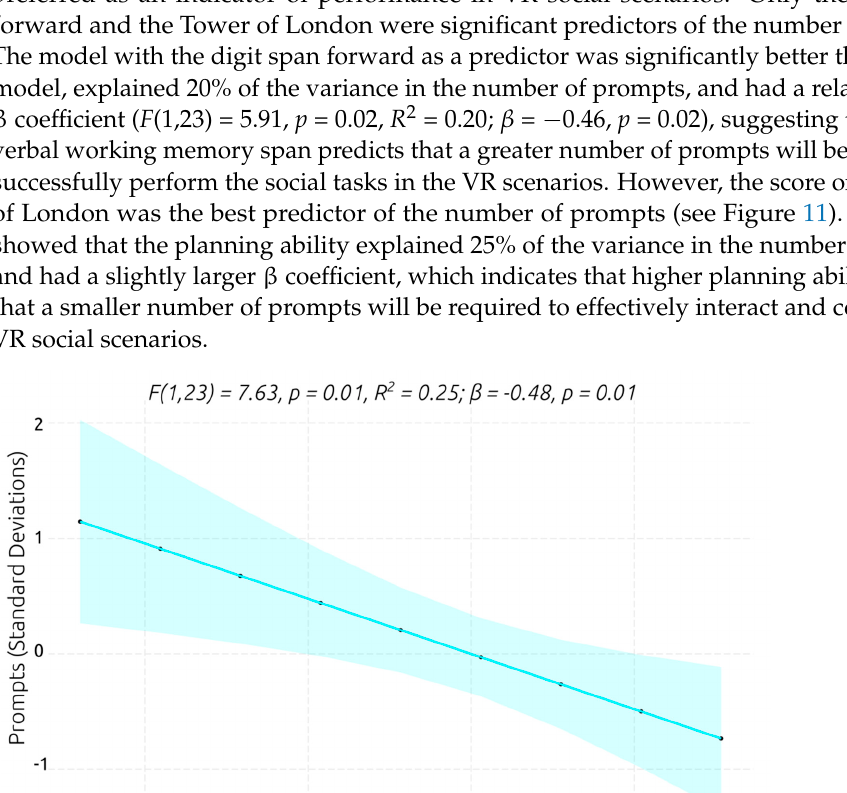
Figure 10. Best generalised linear model for predicting ASD functionality level.